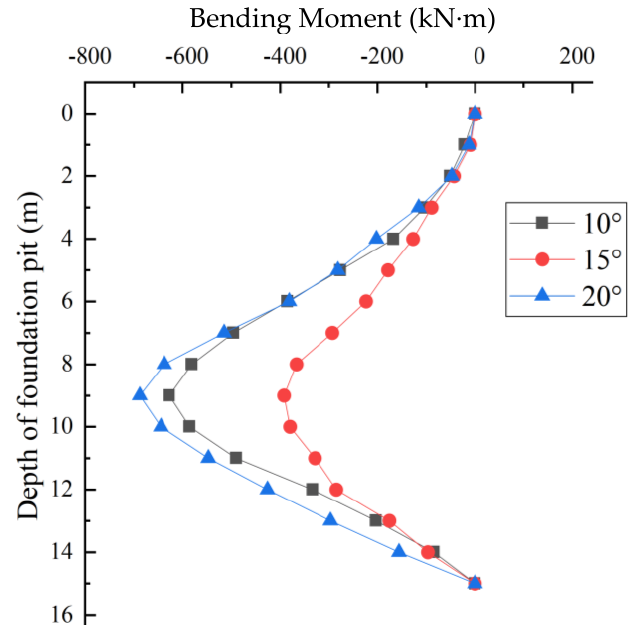
Figure 16. Pile bending moments.